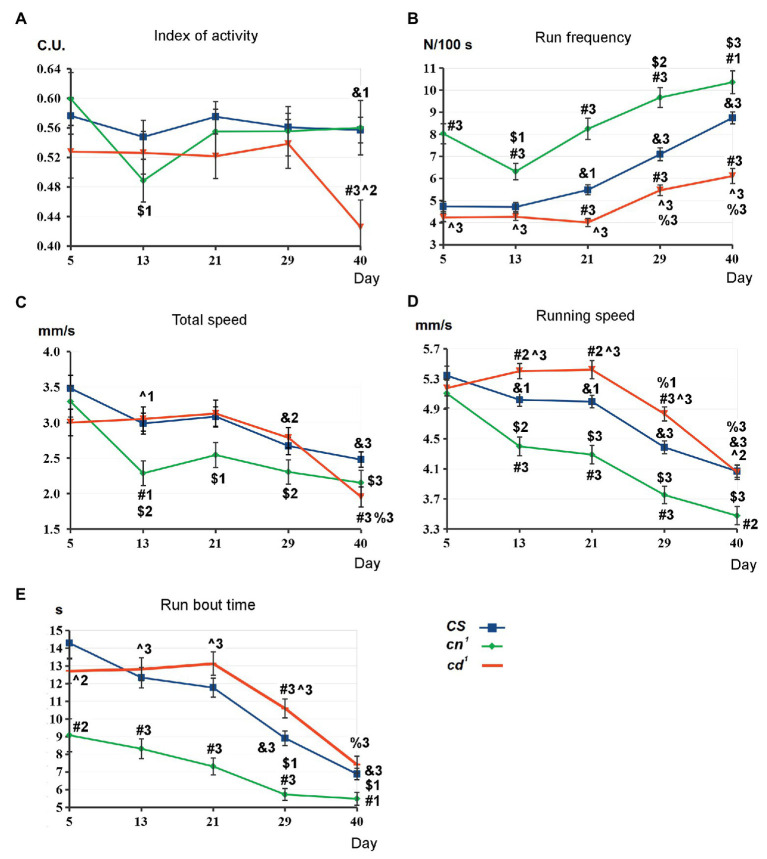
Spontaneous locomotor activity (SLA) parameters for kynurenine mutants. Statistical differences: # from Canton-S (CS), ^ from cinnabar (cn1), & from 5-day-old CS, $ from 5 day-old cn1, and % from 5 day-old cardinal (cd1). Method of analysis: two-tailed Mann-Whitney U-test, p < 0.05 (1), p < 0.01 (2), p < 0.001 (3); for CS: n = 163 (day 5)–143 (day 40), the average data of seven independent experiments; for cn1: n = 47 (day 5)–32 (day 40), the average data of two independent experiments; for cd1: n = 118 (day 5)–108 (day 40), the average data of five independent experiments. Here and below: mean values with standard error are shown (A-E): see in the text.